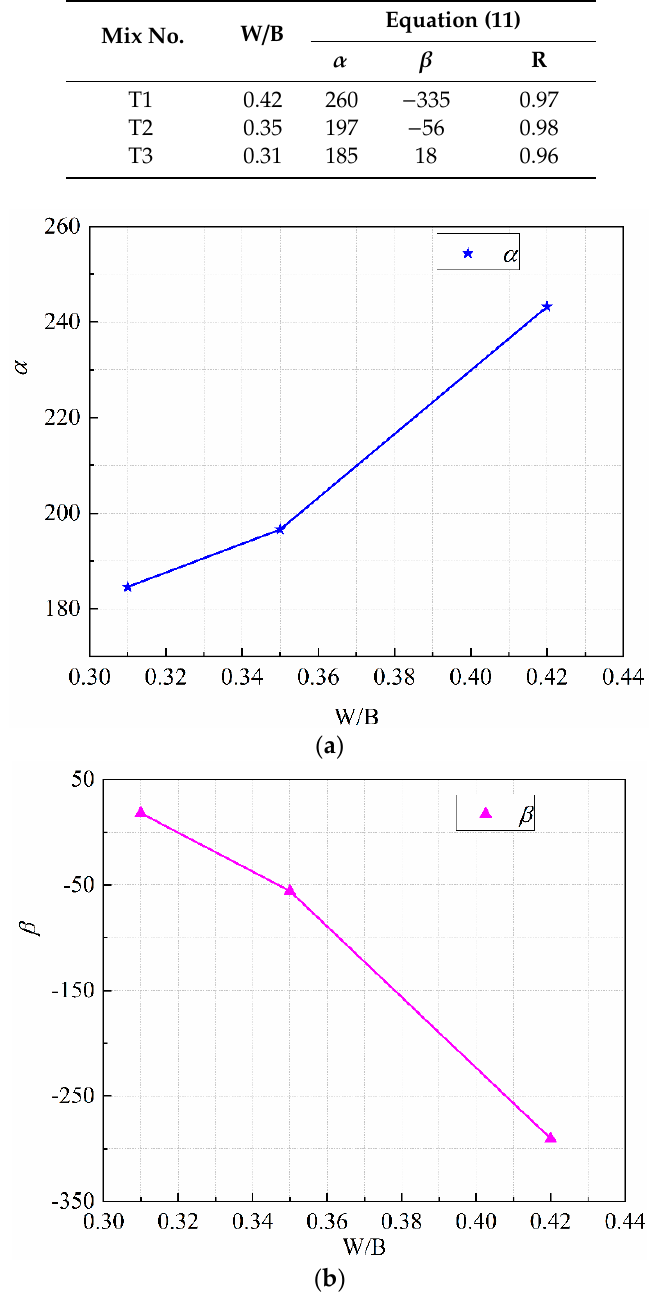
Figure 11. Variation of coefficients α and β with water binder ratio: ( a ) α ; ( b ) β .